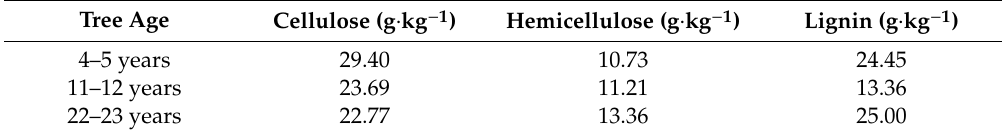
Table 2. Biochemical composition of rubber tree leaves.